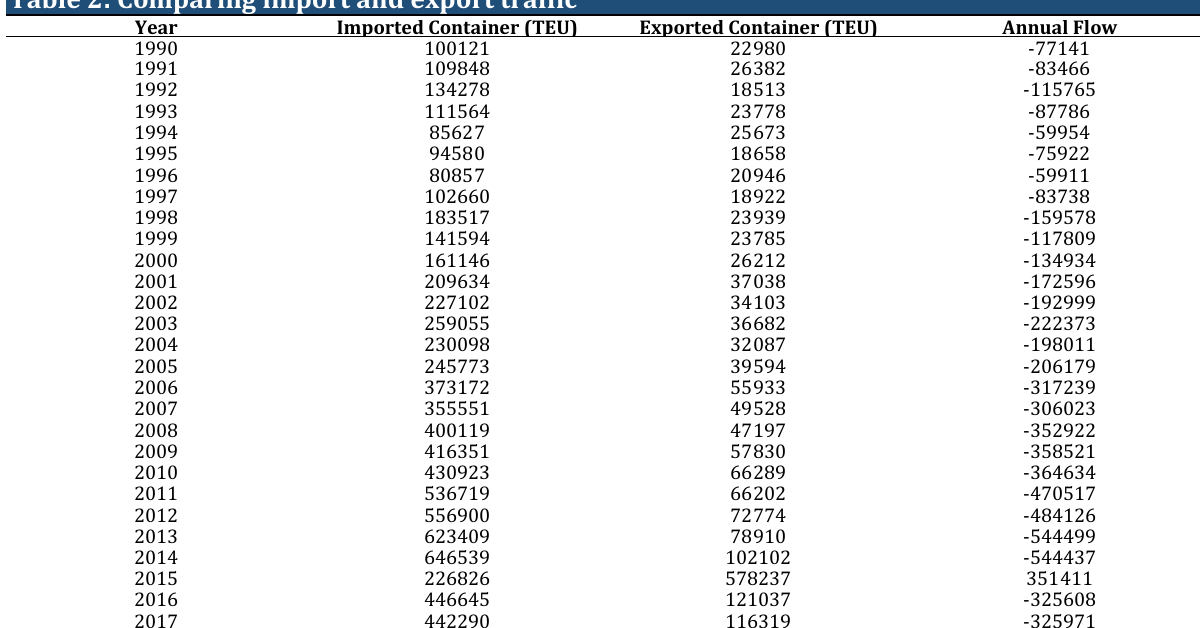
Table 2: Comparing import and export